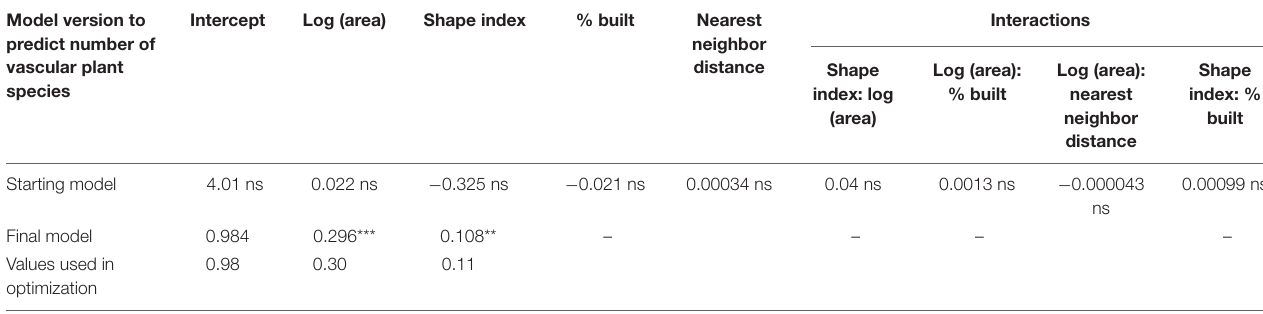
TABLE 3 | Generalized linear model for count data [in R : glm ( y ∼ x , family = quasipoisson)], explaining vascular plant species richness. Model version to predict number of